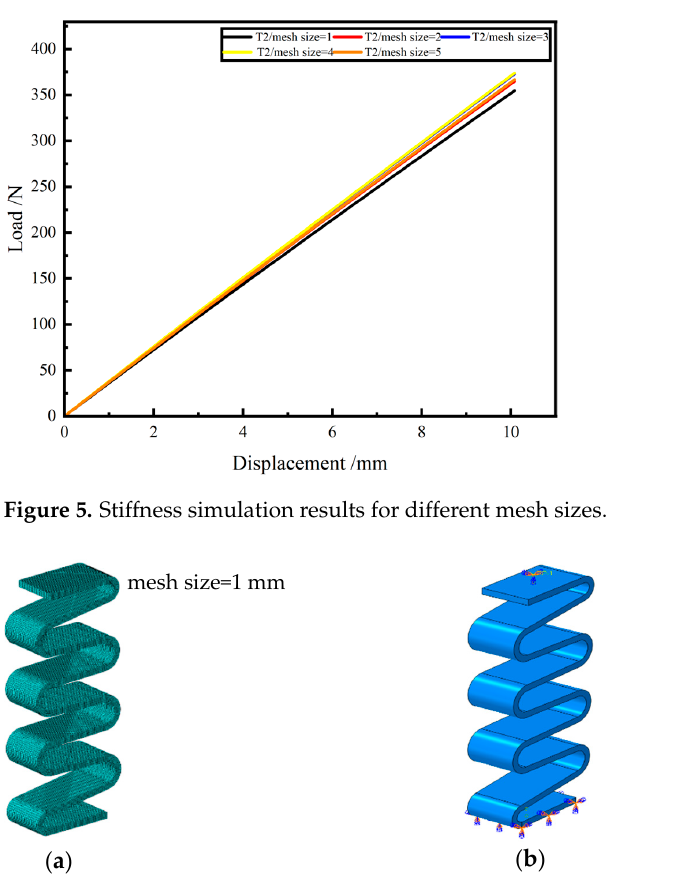
Figure 6. Schematic diagram of finite element simulation analysis model setting, ( a ) Finite element model of wave spring, ( b ) Simulation boundary condition settings.